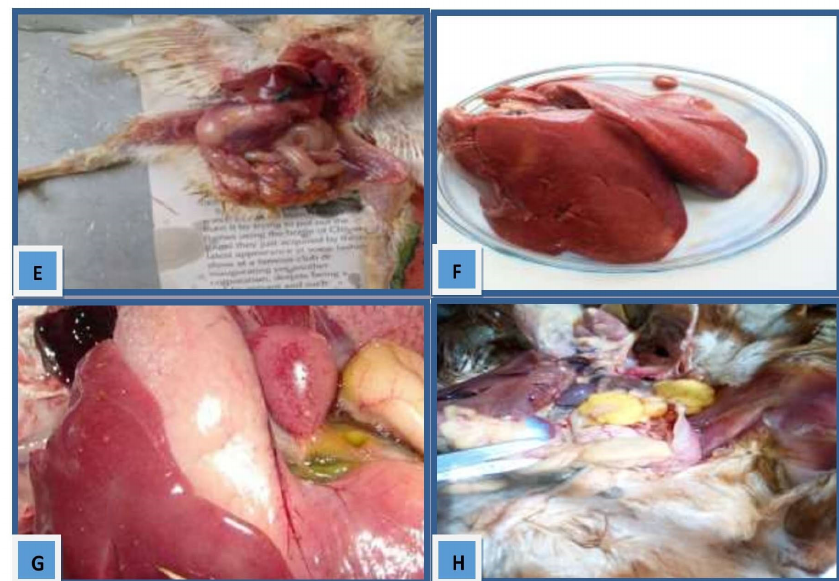
Fig. 5. Gross lesions found in chickens in case of salmonellosis. E: Unabsorbed yolk mass F: Bronze discoloration and